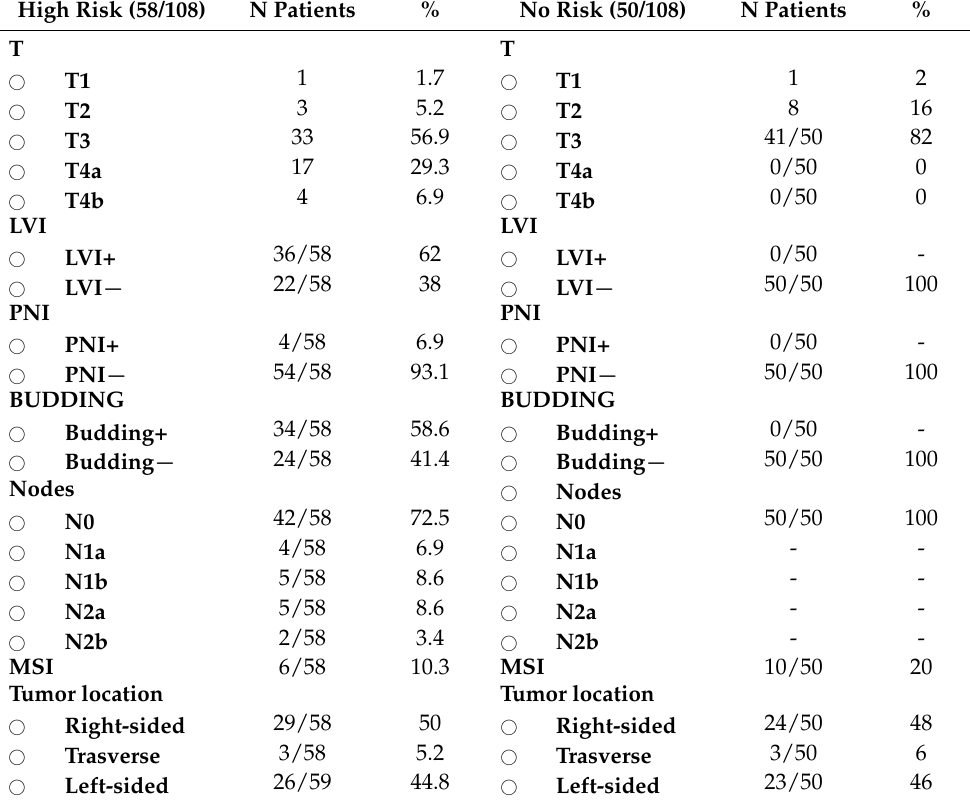
Table 1. Patient clinical